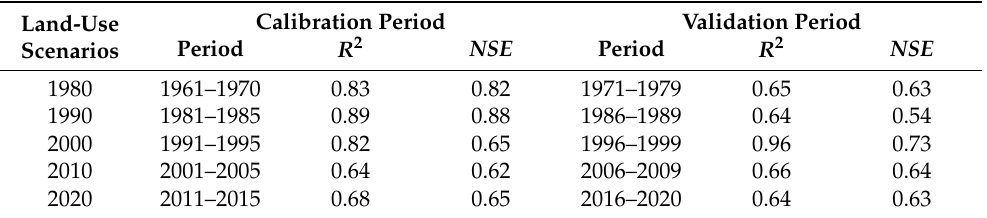
Table 5. Results of the evaluation of monthly flow simulation accuracy of the Huangbizhuang